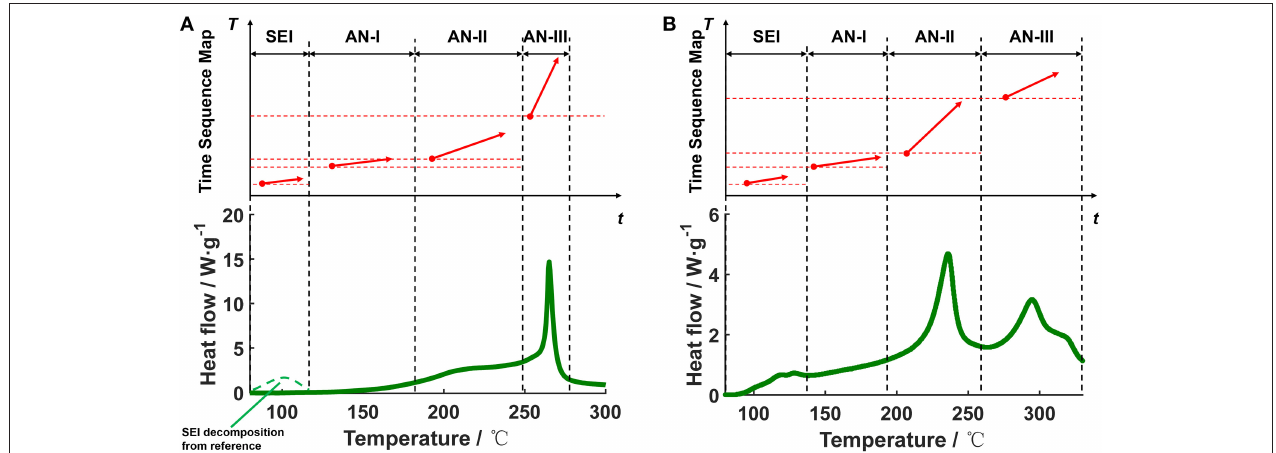
FIGURE 8 | Transformation of the DSC data into the segments in the Time Sequence Map, for the anode system SYS ELE AN of (A) Battery Sample A, (B) Battery Sample B.